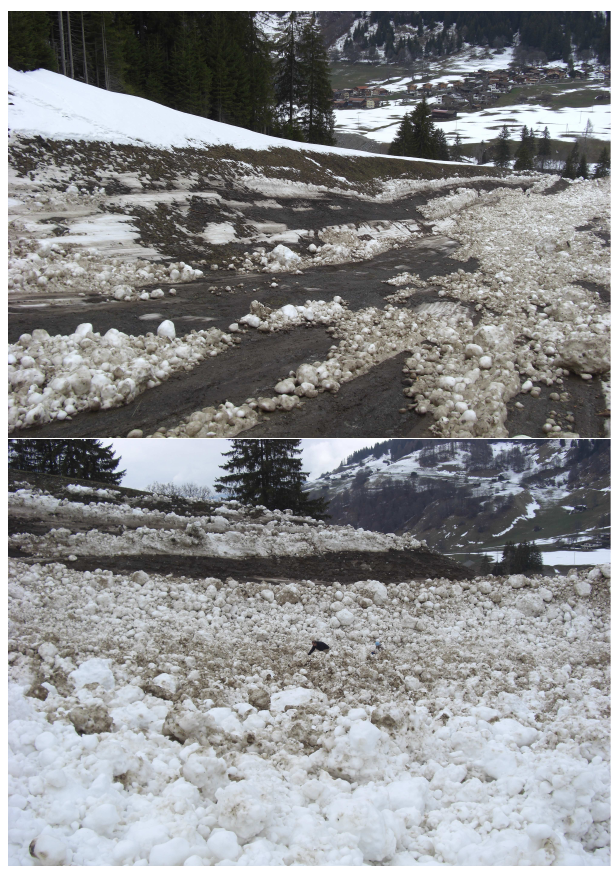
Fig. 8. Avalanche run-up along the side of the dam. Beside the dam, the ground is exposed and traces of glide are visible (upper panel). Far from the dam, deposition depths are up to 2–3m on similar slope angles (lower